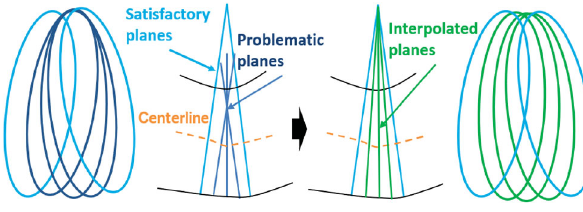
Fig. 6 Replacing intersecting CSs with interpolated